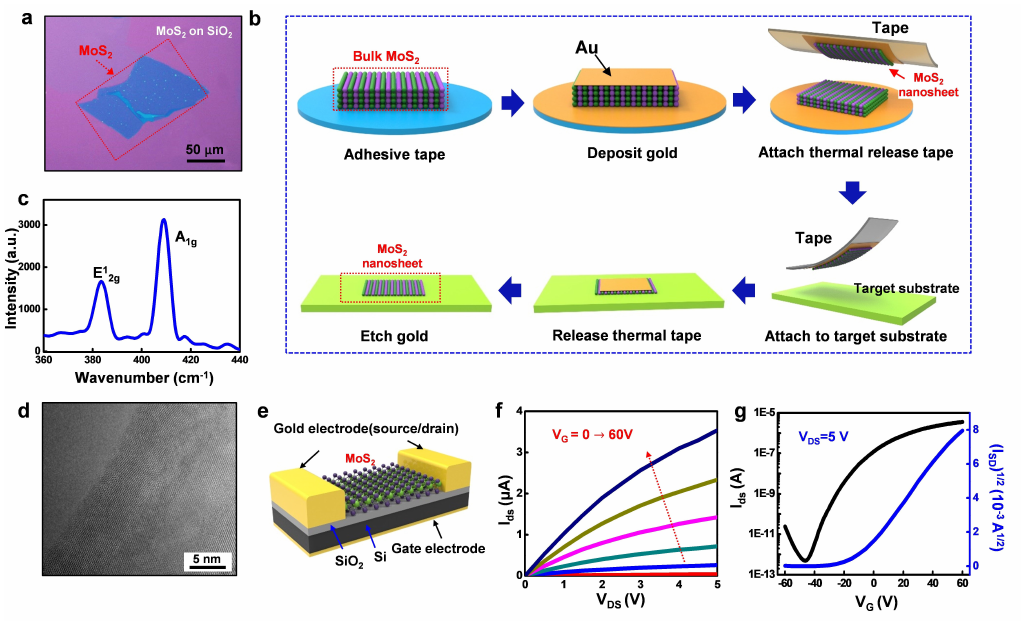
Figure 3. Transfer process, material and electrical characterization of the MoS 2 nanosheet: ( a ) Optical image of exfoliated few-layer MoS 2 with the lateral size of ~120 nm. ( b ) Illustration of the gold-mediated exfoliation process. ( c ) Room-temperature Raman spectrum of few-layer MoS 2 . ( d ) High-resolution TEM images of the atomic layer of MoS 2 . ( e ) Three-dimensional schematic view of the back-gated transistor on the SiO 2 / Si substrate. ( f ) A typical output curve (I DS vs. V DS ) with the back-gate voltage V G sweep from 0 to 60 V. ( g ) Transfer curve (I DS vs. V G ) with V DS = 5 V, the black curve shows the log scale, the blue curve is the square root of I DS